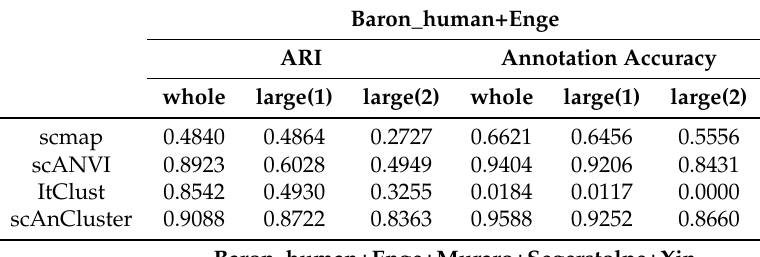
Table 3. Performance of scmap, scANVI, ItClust and scAnCluster on three groups of inter-datasets, that is, “Baron_human”(source) and “Enge”(target), “Baron_human”(source), “Enge”(target), “Muraro”(target), “Segerstolpe”(target) and “Xin”(target), “Macosko”(source) and “Shekhar”(target). “whole” refers to the experiments with complete data. “large(1)” and “large(2)” refer to the deletion of overlapping cell types with the largest and first two largest sizes from the source dataset, respectively.